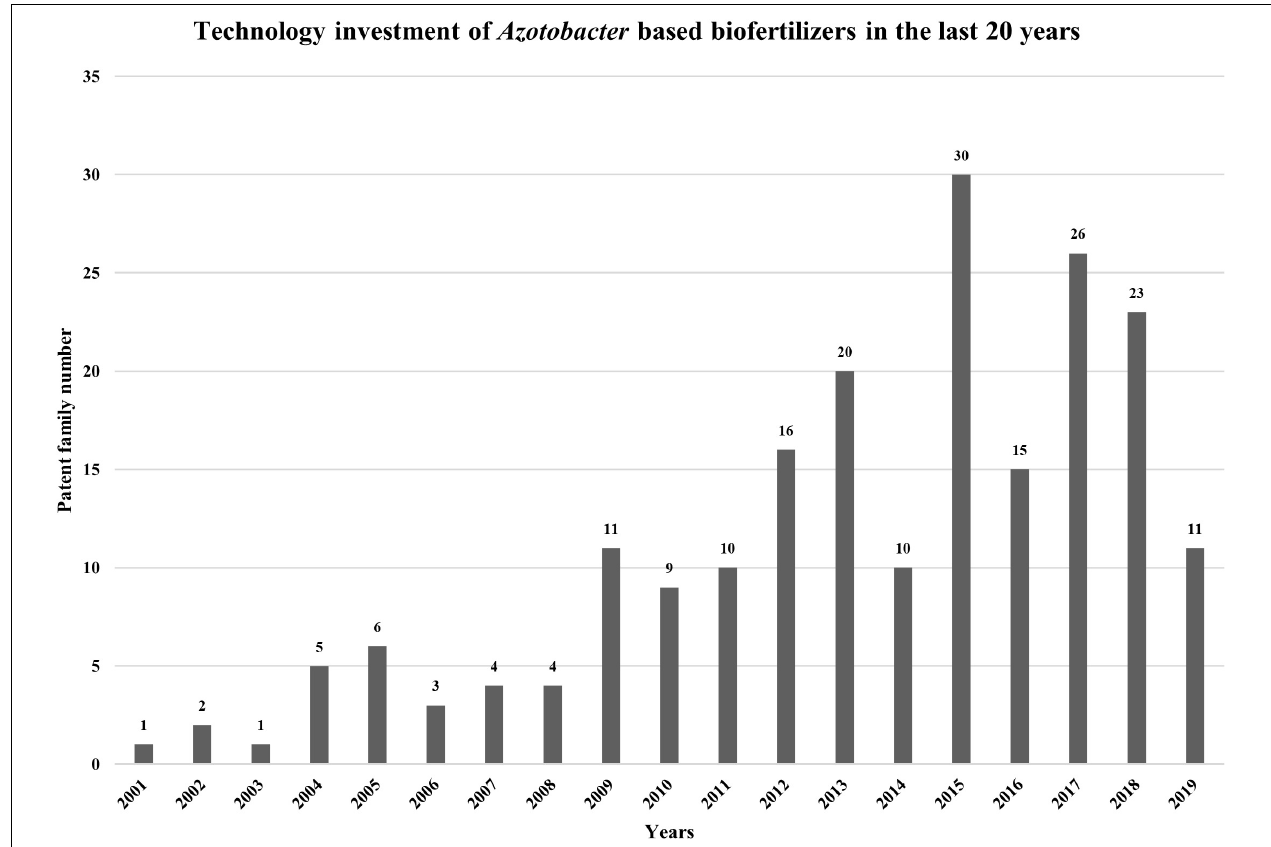
FIGURE 5 | Technology investment and the evaluation dynamics of inventiveness of the studied of biofertilizers based on Azotobacter bacteria in the last 20 years.